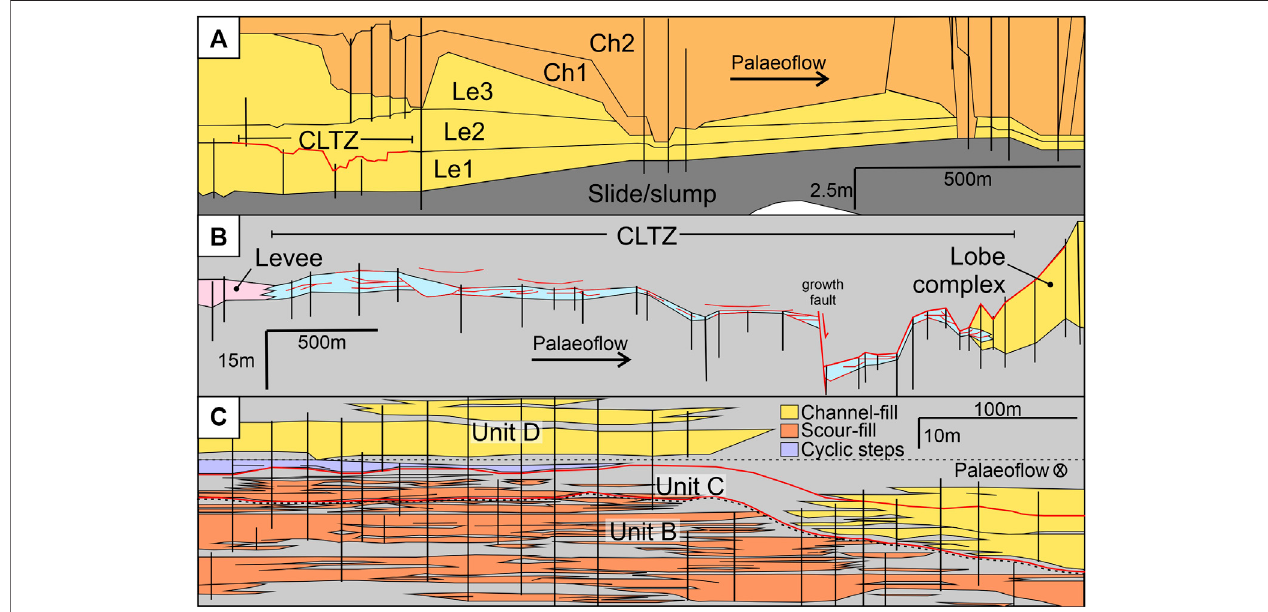
FIGURE 10 | Compilation of outcrop panels of interpreted channel mouth settings, where black vertical lines are locations of measured sections. (A) A CLTZ as a surface as the base of lobe element (Le) 2 at the Bridges of Ross outcrop, Loop Head Peninsula, County Clare, western Ireland (adapted from Pyles et al., 2014). (B) A thinCLTZinUnitE3,FortBrownFormation, Laingsburgdepocentre,KarooBasin,SouthAfrica,inabase-of-slopelocation(adapted fromBrooksetal.,2018).Redlines are scour surfaces, and the aquamarine unit is the interpreted CLTZ, which is < 10 m thick. Note the growth fault, and the abrupt thickening downdip of the sand- rich lobe complex (yellow). (C) A thicker succession recording the overall progradation of a lower slope succession with a large number of scour- fi lls, and local cyclic steps, belowand adjacent tostackingchannel elements from the TresPasos Formation,Magallanesretroarcforeland basin insouthern Chile (adapted from Pemberton et al., 2016). Herein we suggest that this is a candidate